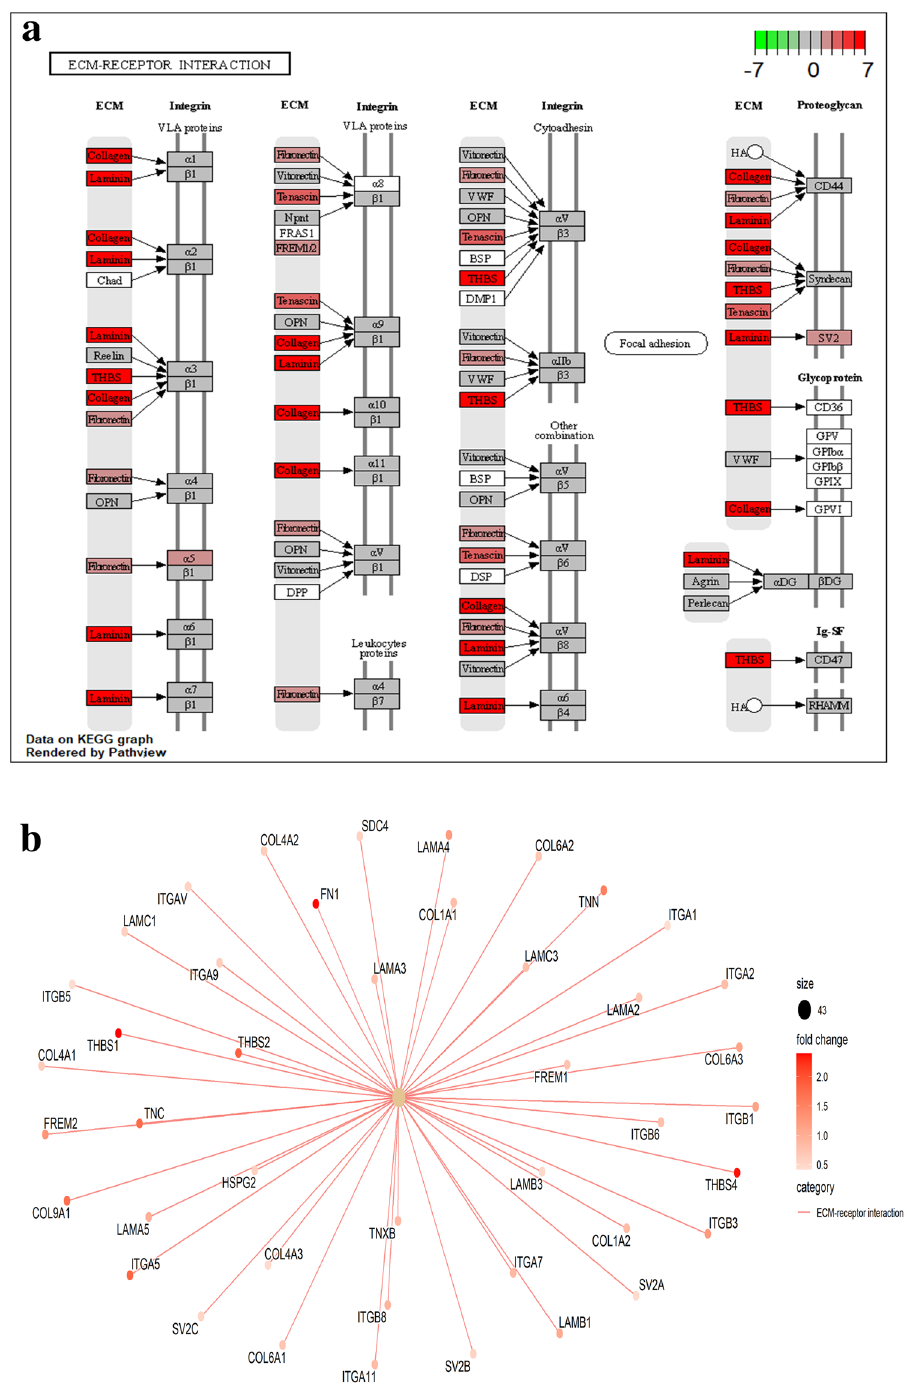
Figure 8. ( a ) The ECM-receptor interaction 47 , an important KEGG pathway, indicated by up-regulated genes in the high diarrhoea group. ( b ) A category Netplot (CNET) showing the relationships among genes in ECM- receptor interaction